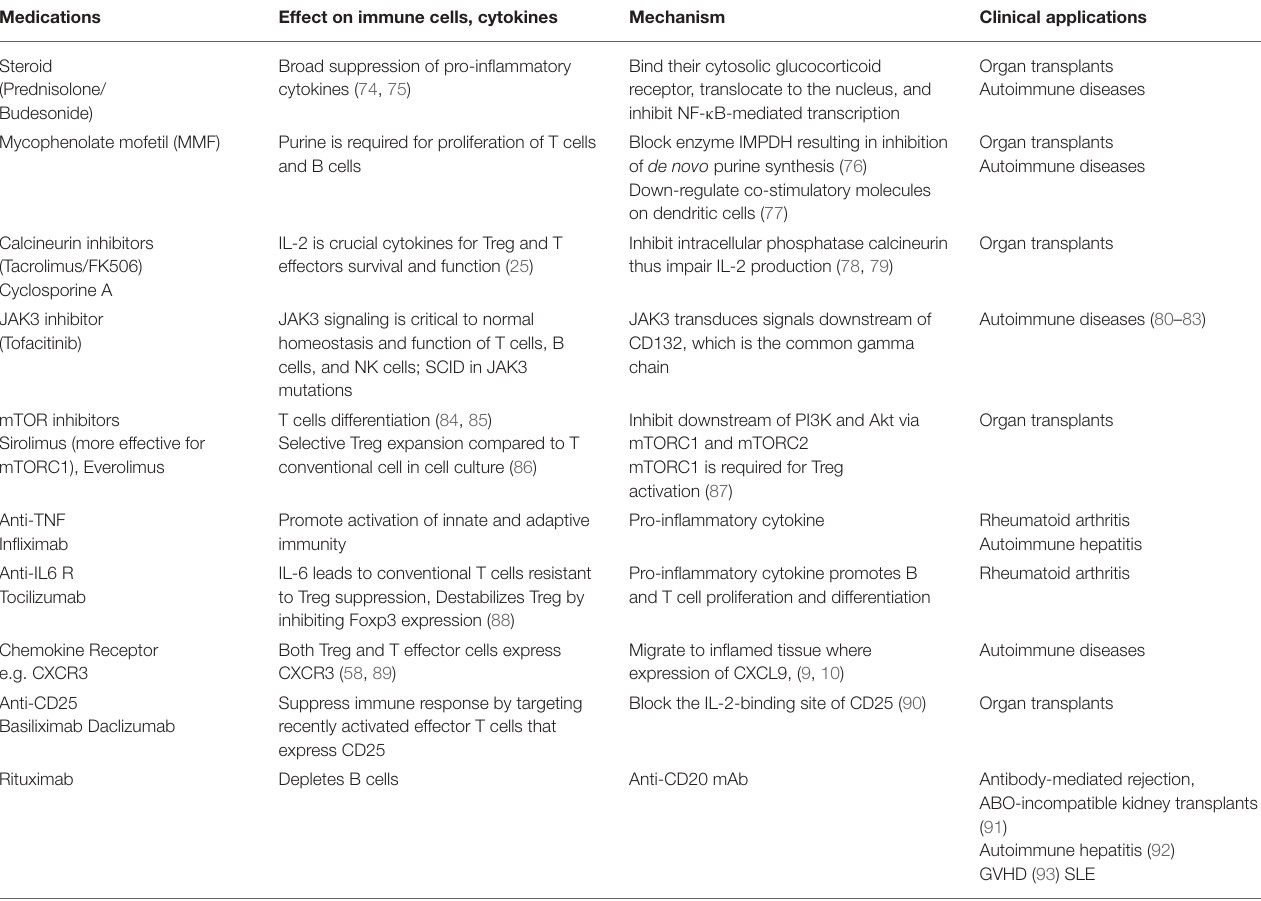
TABLE 2 | Immunosuppressive medications applied in autoimmunity and transplantation with their mechanisms, and impact on immune systems. Medications Effect on immune cells, cytokines Mechanism Clinical